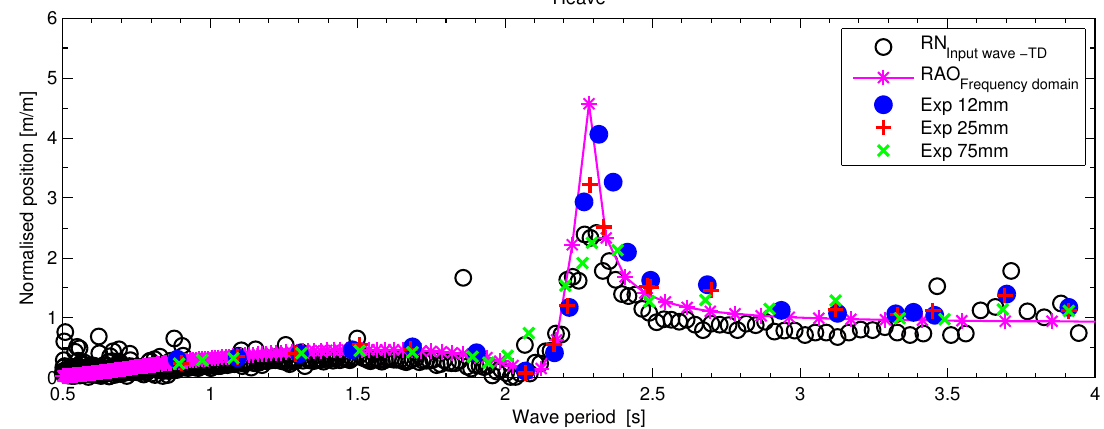
Figure 10. Heave response amplitude operator (RAO) (from the frequency domain) alongside the normalised response from the time domain results of the panchromatic waves ( RN input wave − TD ). Experimental measurements for the regular waves of amplitude 12 mm, 25 mm, and 75 mm are also shown.